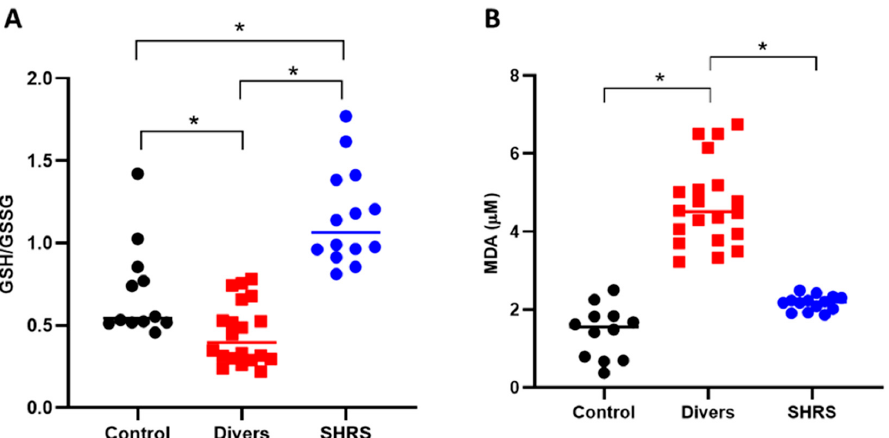
Figure 4. Effect of different types of exercise on serum redox environment: control ( n = 12), diver ( n = 20) and SHRS ( n = 14) groups. ( A ) GSH/GSSG ratio and ( B ) MDA serum levels. Data are represented by the median. * p < 0.05 based on the Kruskal–Wallis test with Dunn’s test for multiple pairwise comparisons.